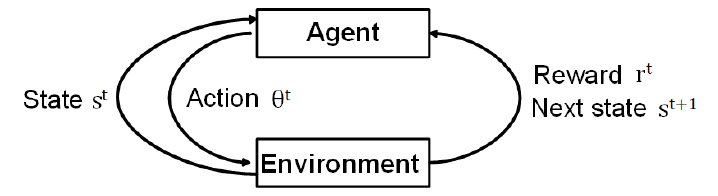
Figure 2. Typical reinforcement learning (RL)